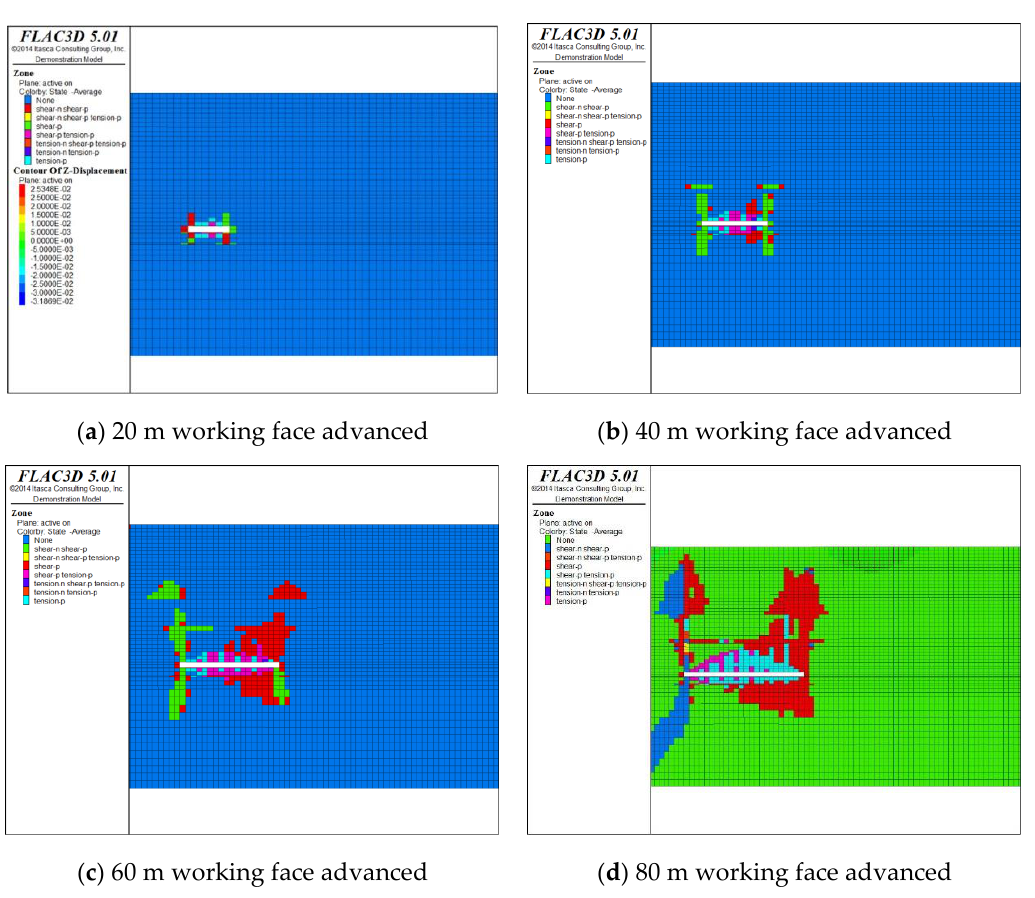
Figure 7. Distribution of plastic zones with different degrees of stoping below the